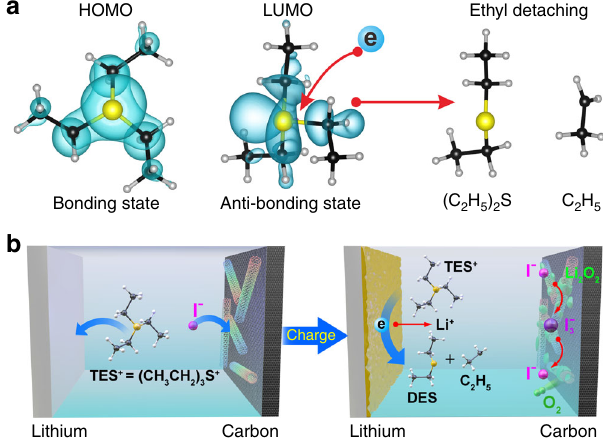
Fig. 1 In-situ formation process of SEI-like layer on Li anode. a Calculated HOMO and LUMO orbitals of a TES + cation. b Schematic illustration of the in-situ formation process of SEI-like layer on Li anode during